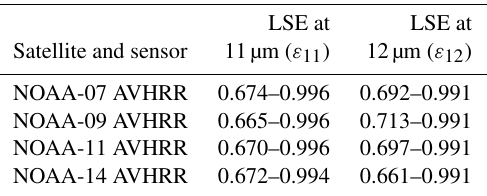
Table 2. Global LSE ranges determined from JHU spectral emis- sivity library for AVHRR channel centered at 11 and